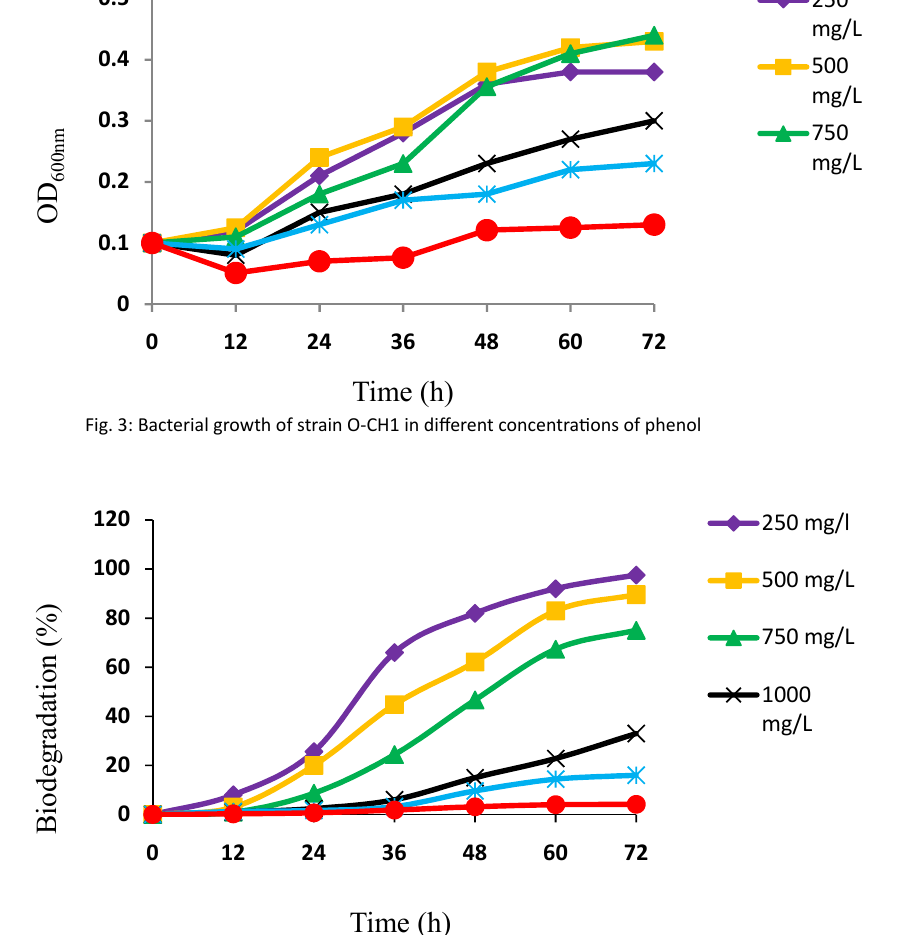
Fig. 4: Percentage of phenol degradation by strain O‐CH1 in different concentrations of phenol